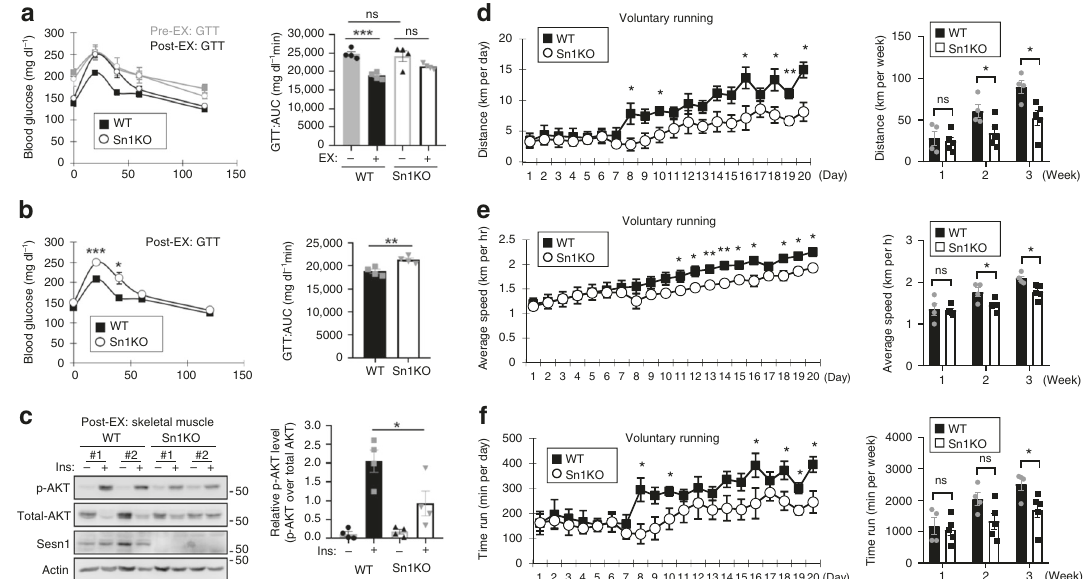
Fig. 3 Sesn1 is required for exercise effects on glucose tolerance and running pro fi le. a – c 2-month-old WT and Sesn1 − / − (Sn1KO) mice (C57BL/6 background) were analyzed by glucose tolerance test (GTT) with area-under-curve (AUC) analysis ( a , Pre-EX). When the mice reached 6 months of age, they were subjected to voluntary wheel running for 2 months, and analyzed by GTT ( a , b ; Post-EX) and acute insulin response assay ( c ). Post-EX data were plotted with ( a ) or without ( b ) Pre-EX data for cleaner comparisons between groups. Insulin-induced AKT activation of skeletal muscle was analyzed by immunoblotting and band densitometry. d – f 6-month-old WT and Sesn1 − / − mice were subjected to voluntary wheel running. Daily (left panels) and weekly (right panels) running distance ( d ), speed ( e ) and time ( f ) were recorded for the fi rst three weeks of voluntary wheel running. Biologically independent animals: n = 4 ( a – c ), n = 4, 5 ( d – f ; WT and Sesn1 − / − mice, respectively). Error bars, s.e.m. * P < 0.05, ** P < 0.01, *** P < 0.001 or ns, non-signi fi cant from a two-tailed student ’ s t test. Molecular weight markers are indicated in mitochondrial biogenesis, were also reduced in TKO muscle (Fig. 5c). Markers for mitochondrial complexes, including SDHA, SDHB, NDUFS3, ATP5B, and UQCRFS1, were all signi fi cantly decreased in TKO muscle compared to WT (Fig. 5c). These phenotypes were more pronounced in gastrocnemius (GTN) and quadriceps (QUAD) muscles; expression levels of PGC1 α / β , PGC1 target proteins and mitochondrial enzymes were all strongly reduced in TKO tissues (Fig. 5d, e), and the same trend was observed in quanti fi ed mRNA levels (Supplementary Fig. 6a) and histological assessment of mitochondrial complex activities (Fig. 5f, g). Muscle mass was also reduced in both SOL and GTN (Supplementary Fig. 6b – d); however, speci fi c force production normalized for the reduced muscle cross-sectional area was comparable between WT and TKO muscle tissues (Supplementary Fig. 6e), suggesting that the exercise de fi cits in TKO mice are not due to the impairment of muscle contractility. Transmission electron microscopy of GTN muscle showed that the overall microstructure of sarcomeres and mitochondria are not noticeably different between WT and TKO mice (Supple-